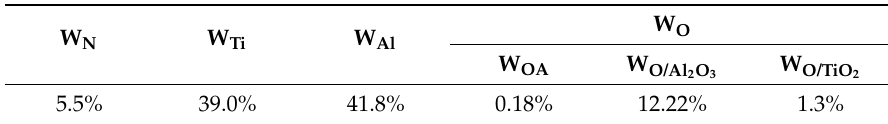
Table 2. Mass fractions of the elements in the nanopowders and those of oxygen in different phases. See the text for details.